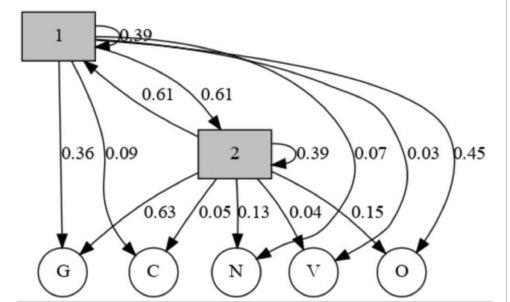
Figure 9. The emission and transition probabilities of the developed hidden Markov model. The hidden states 1 and 2 mark the absence and presence of a consistent decline in five major HRV components, respectively. The observations G, C, N, V, and O mark the SARS-Cov-2 symptoms reported by the participants.